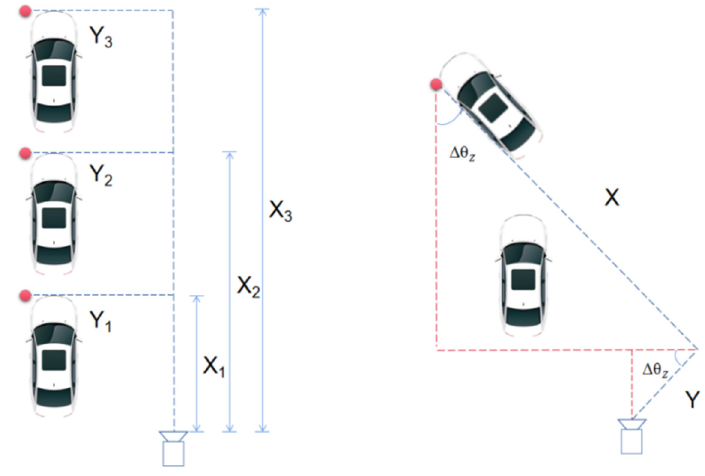
Figure 7. Determination of vehicle location in straight and curved paths.